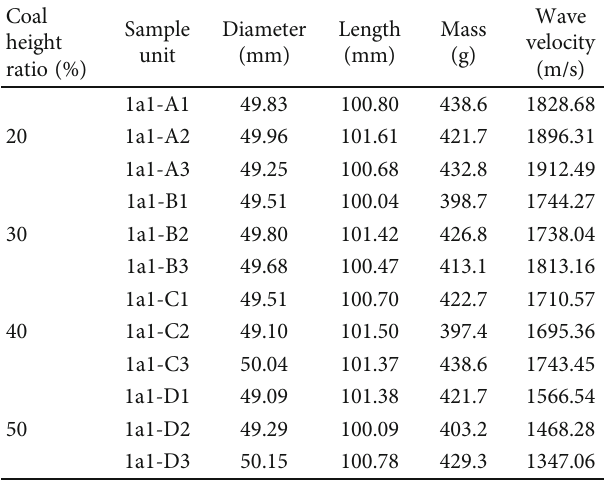
Table 2: Physical properties and initial wave velocity of RCRCS. Coal height ratio (%)